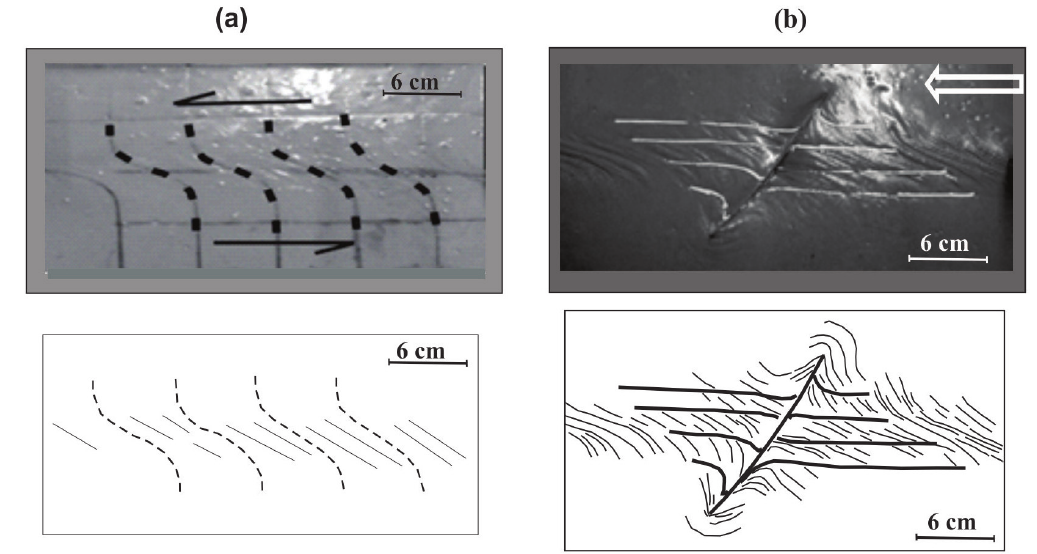
Figure 7 - Photographs and line drawings of the silicone flow trajectory after a sinistral simple shear of γ = 0.8 ( 5 cm of linear dislocation) in previous models. ( a ) Without the CE and monitored by an initial square grid. ( b ) With the CE in a model set up with four horizontal marker horizons. In the photographs, silicone is grey; the thin double arrows indicate the bulk simple shear and the thick arrow shows the movement of the upper half of the experimental box.